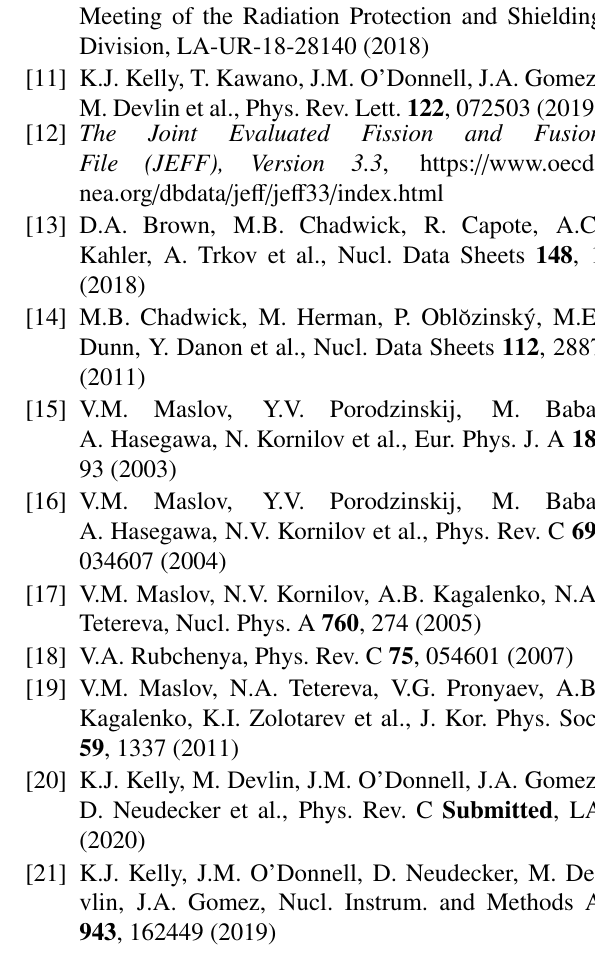
Figure 4. The trend of the average PFNS energy, respectively. Relevant evaluations are plotted as well for comparison. The 239 Pu and systematic components to demonstrate the importance of identifying and quantifying all possible sources of systematic uncertainty. The 235 U only has a subset of the total known systematic uncertainty applied for the data in this